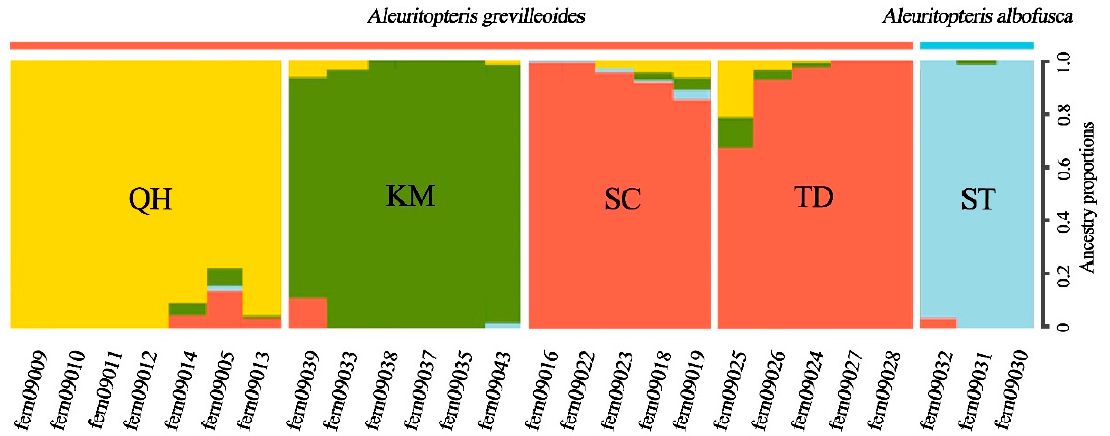
Figure 1. Analysis of Population Structure. Note: Aleuritopteris grevilleoides include QH (yellow), KM (green), SC (red), and TD (red); A. albofusca is ST (blue).